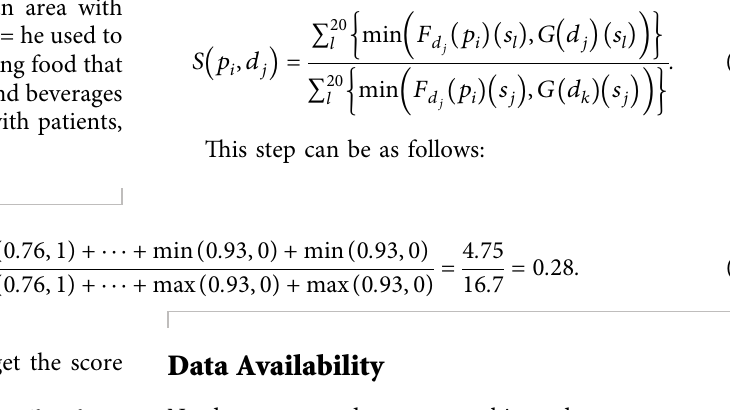
Table 23: Tabular representation of ( F